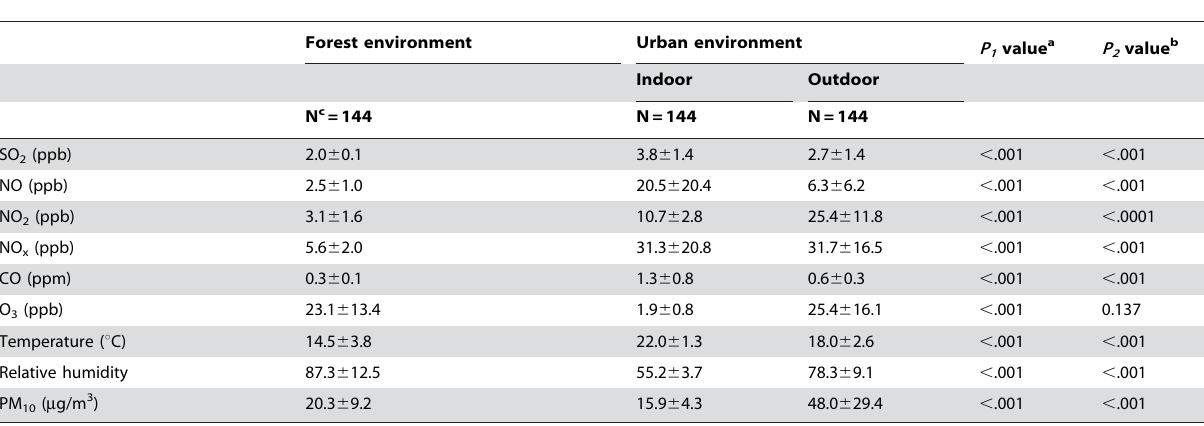
Table 4. Environmental monitoring in forest and urban